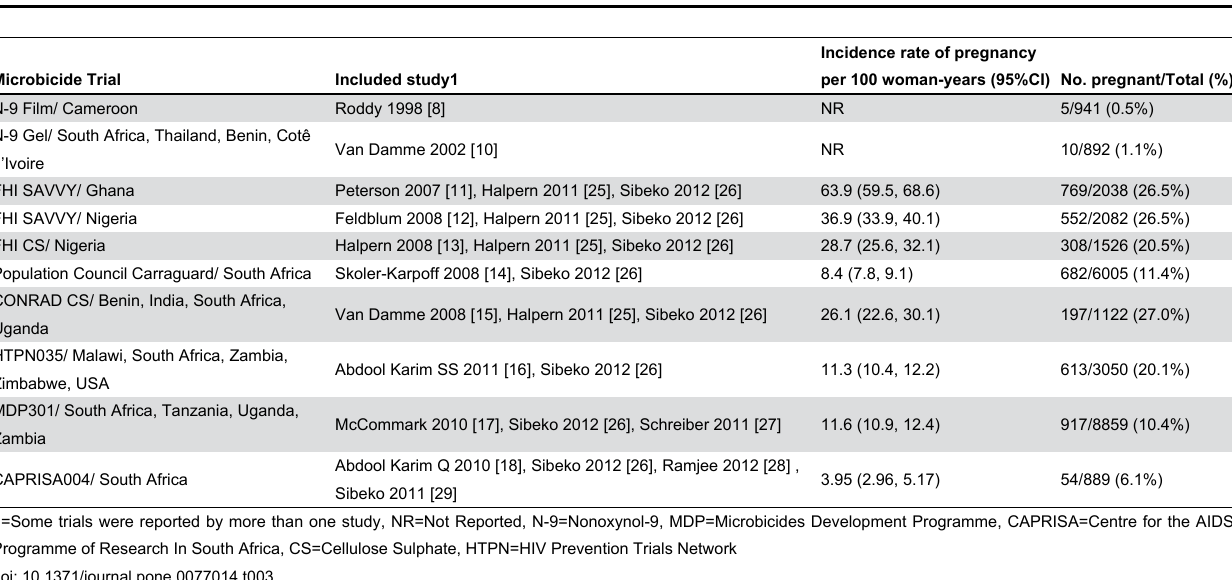
Table 3. Pregnancy data for included studies.